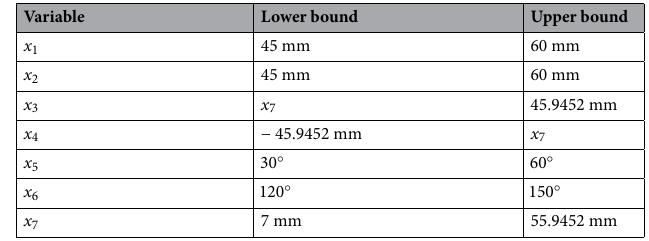
Table 2. Lower and upper boundaries on x for optimization. Constraints were set within the limits of the motor armature. The wheel’s radius was 64.6 mm and the workspace of each configuration had an offset of 5% with respect to the